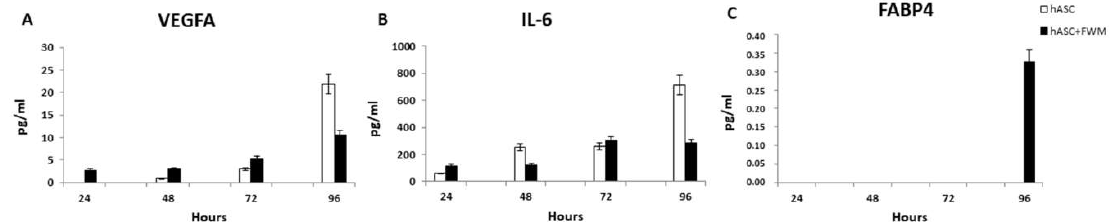
Figure 6. Histograms of enzyme-linked immunosorbent assay (ELISA) quantification of ( A ) VEGFA, ( B ) IL-6 and ( C ) FABP4 in the culture medium of hASCs grown in presence ( + FWM) or not ( − FWM) of FWM (n = 3).